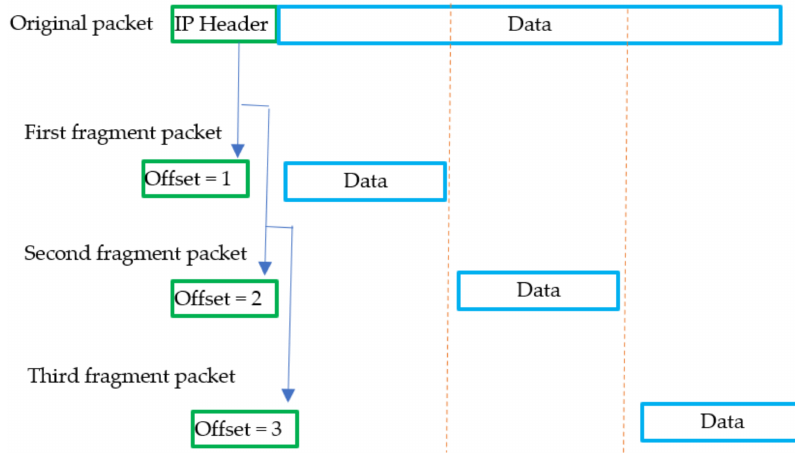
Figure 7. IP packet fragmentation in the network layer.